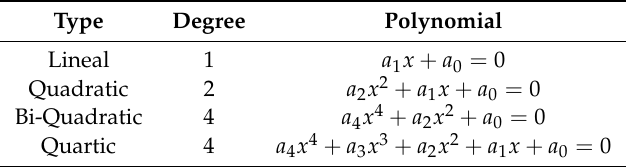
Table 5. Possible types of polynomial equations that can be encountered when solving the final basis.